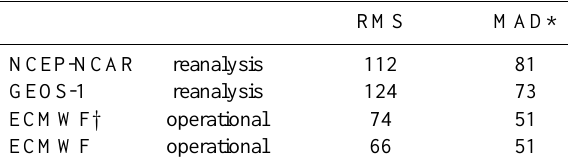
Table 2. S 1 differences ( µ b) with 25 ocean